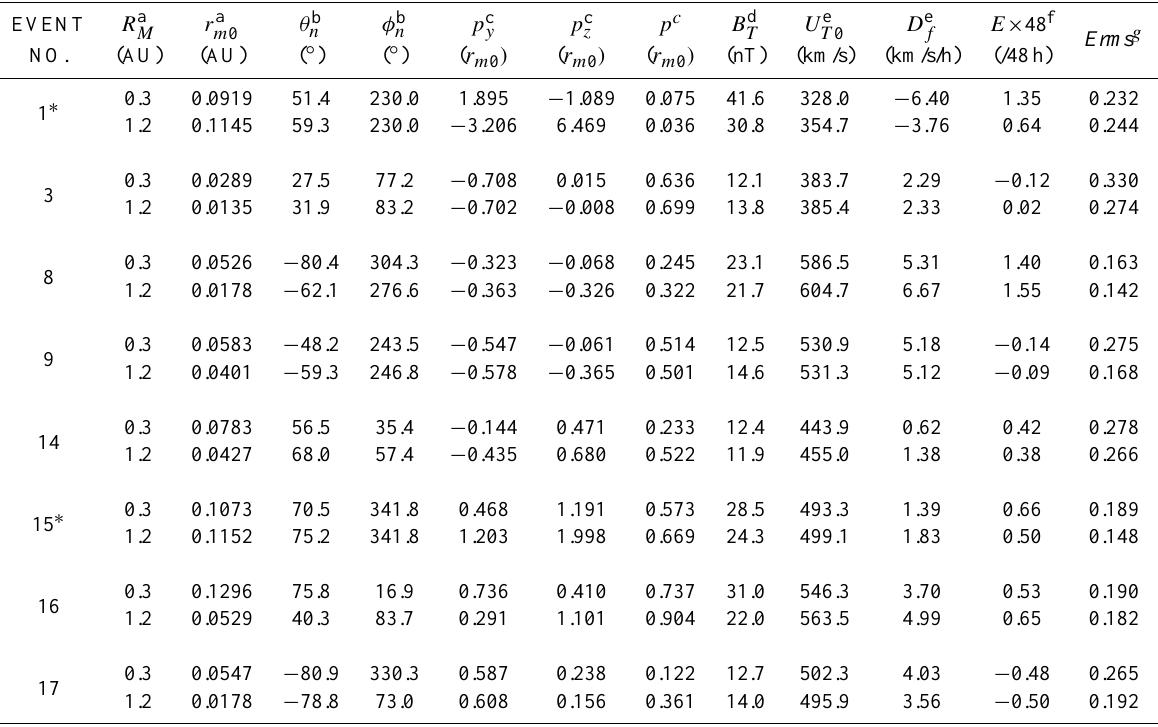
Table C1. Magnetic cloud parameters for R M =0.3AU, and for R M =1.2AU.